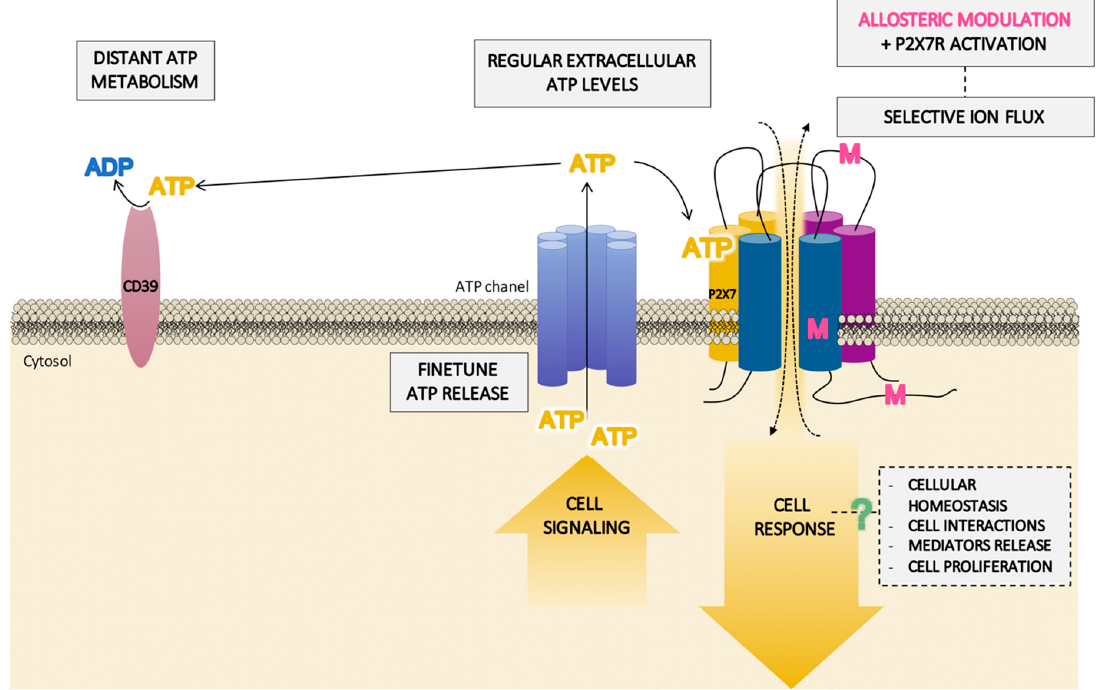
Figure 5. Schematic pathway of the hypothetical role of the P2X7 receptor (P2X7R) in homeostasis balance. In physiological situations, the specific localization of the P2X7R in the membrane, near finetuned adenosine triphosphate (ATP)-released structures and distant from ATP-degrading enzymes, could provide a small extracellular concentration of ATP which are not enough for the activation of the receptor. However, this activation can take place in the presence of a positive allosteric modulator (M) binding to different domains of the receptor. This will facilitate the selective flux of ions through the P2X7R channel, thus inducing a transduction pathway which could lead to a cellular homeostasis response without inducing necessarily cellular damage.